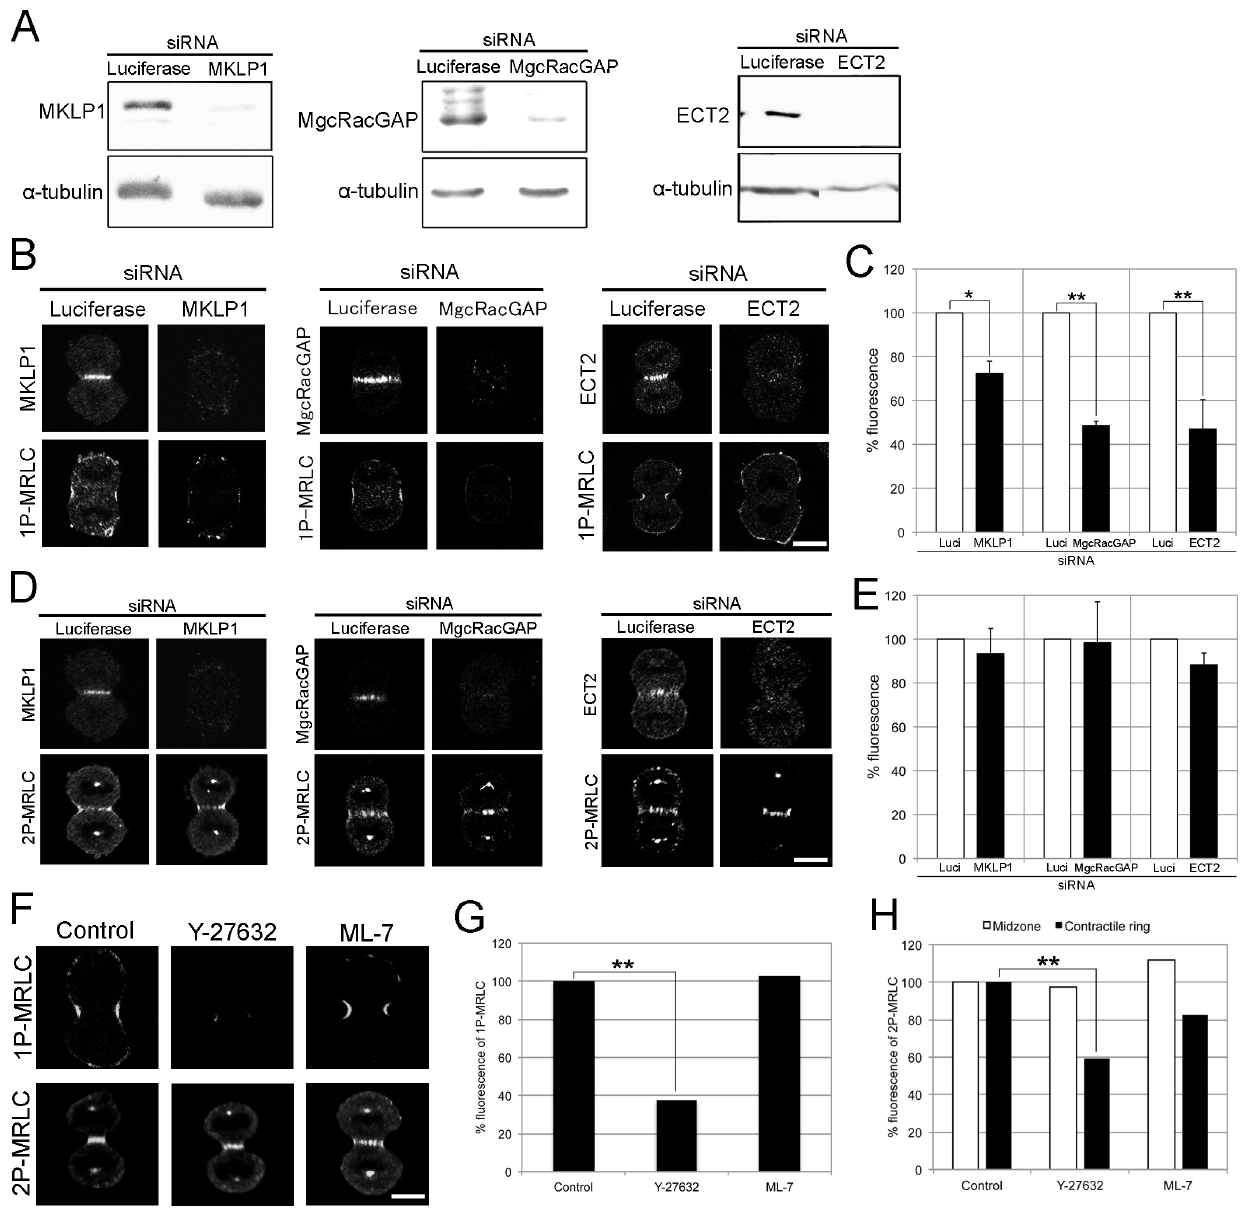
Figure 2. Rho signaling is not required for the localization of 2P-MRLC to the midzone. (A) Western blots for the detection of MKLP1, MgcRacGAP, and ECT2. HeLa cells were transfected with siRNA targeting luciferase, MKLP1, MgcRacGAP, or ECT2, respectively. Loading control: a - tubulin. (B) HeLa cells treated with luciferase, MKLP1, MgcRacGAP, or ECT2 siRNAs were fixed and immunostained with pLC1. Bar, 10 m m. (C) Quantitative analysis of 1P-MRLC fluorescence at the contractile ring in cells depleted of luciferase, MKLP1, MgcRacGAP, or ECT2. The averages of